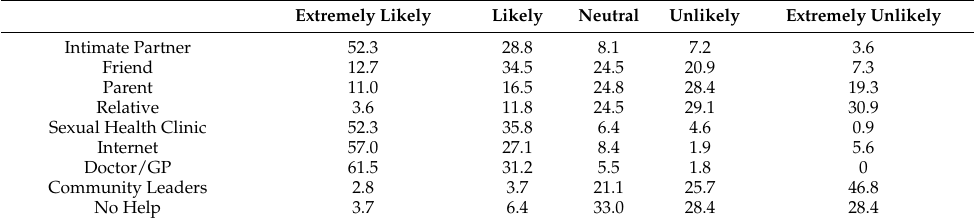
Table 6. Perceived likelihood (%) of SRH help-seeking depending on source. Extremely Likely Likely Neutral Unlikely Extremely Unlikely Intimate